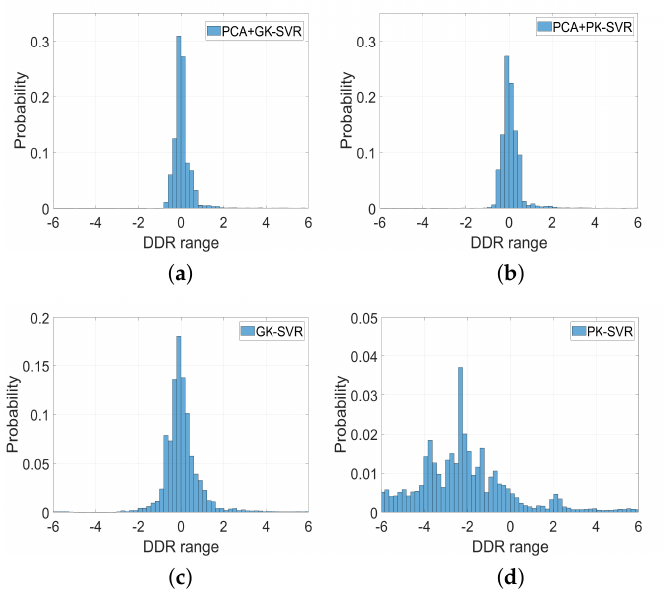
Figure 4. Normalized histogram of the developed discrepancy ratio (DDR) values for the four methods in the training stage. ( a ) PCA + GK-SVM, ( b ) PCA + PK2-SVM, ( c ) GK-SVM and ( d )